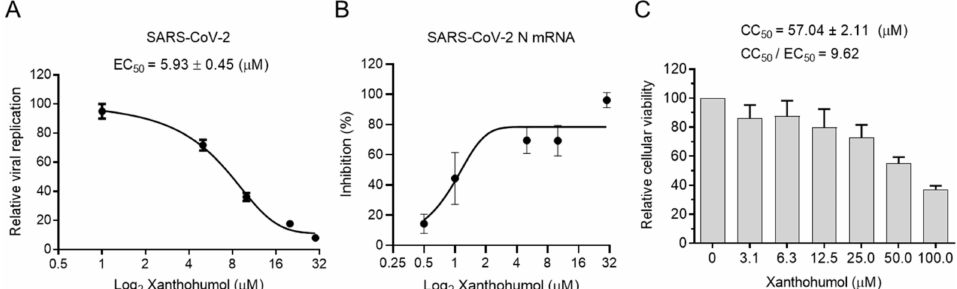
Figure 4. Xanthohumol inhibited SARS-CoV-2 replication in Vero-E6 cells. ( A ) Xanthohumol-inhibited SARS-CoV-2. Vero-E6 cells were pretreated with compounds at indicated concentrations for 1 h, and then infected with recombinant SARS-CoV-2 mNeonGreen virus (MOI = 0.5) for 24 h. The green fluorescence was scanned as described. The EC 50 values of Xanthohumol were calculated and are shown. ( B ) Xanthohumol reduced viral RNA loads. SARS-CoV-2 N mRNA was measured with qRT-PCR and normalized to GAPDH. ( C ) Cytotoxicities of Xanthohumol. Data are shown as means ± SEM from three independent